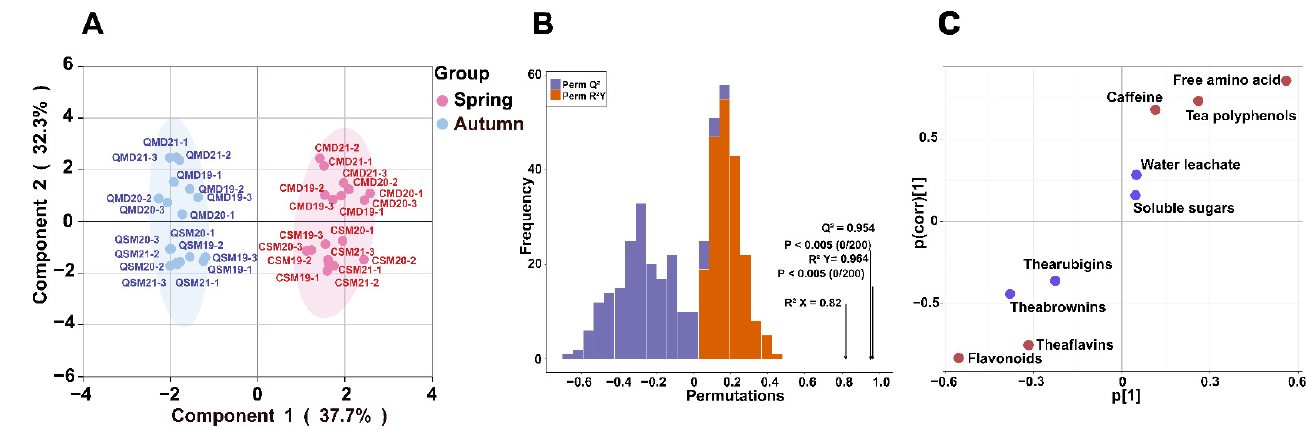
Figure 4. ( A ) OPLS-DA scores scatter plot of non-volatile components; ( B ) OPLS-DA cross-validation result of nonvolatile components; and ( C ) OPLS-plot result. In Figure 4C, the red dots indicate that the VIP value is greater than 1, and the blue dots indicate that the VIP value is less than 1. White teas picked in spring were called SPWTs and those picked in autumn were called APWTs. White peony teas and Shou Mei picked in spring were termed CMD19-21 and CSM19-21, respectively, while those picked in autumn were correspondingly named QMD19-21 and QSM19-21. The number following CMD, QMD, CSM, and QSM represented the production years, corresponding to 2019, 2020, and 2021, respectively. The number after the year indicates a biological duplicate (Table 1).